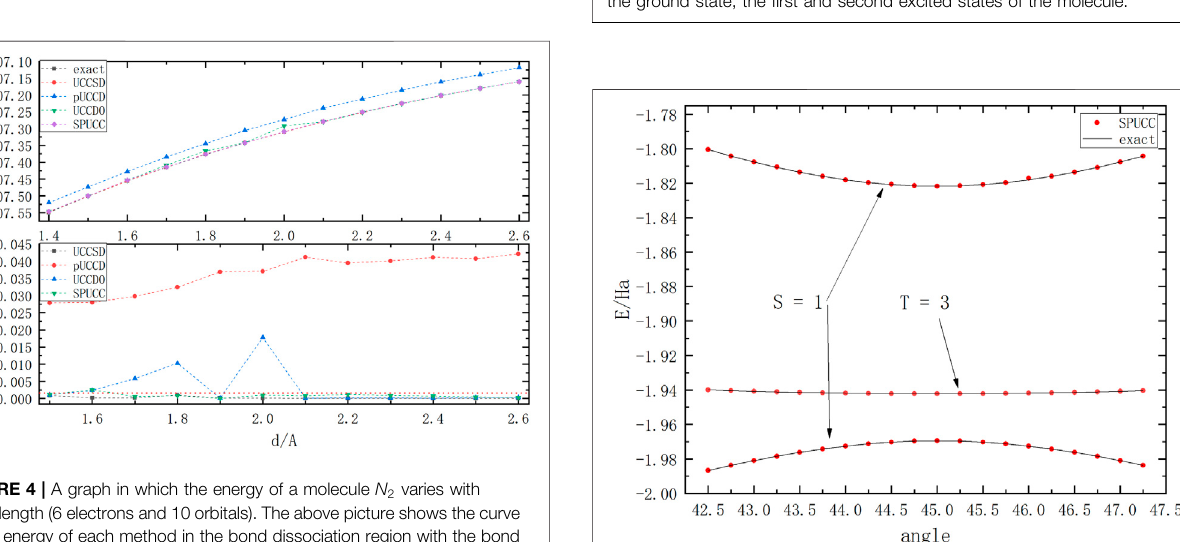
FIGURE 5 | A graph in which the energy of a molecule H 2 O varies with bond length (6 electrons and 10 orbitals). The S (cid:1) 1 represents the singlet state, and the T (cid:1) 3 represents the triplet state. From the bottom up, they are the ground state, the fi rst and second excited states of the molecule.